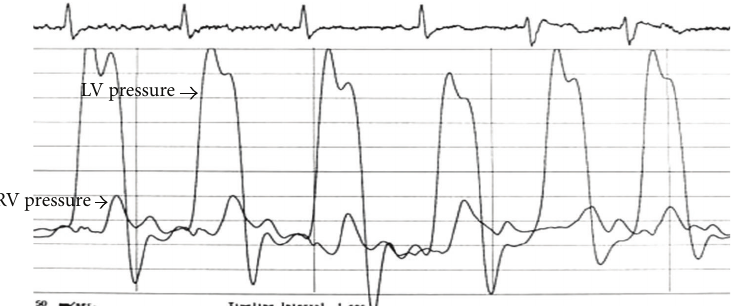
Figure 3: The equalization of diastolic pressures and “square root sign” or “dip and plateau sign” of the left ventricular waveforms.